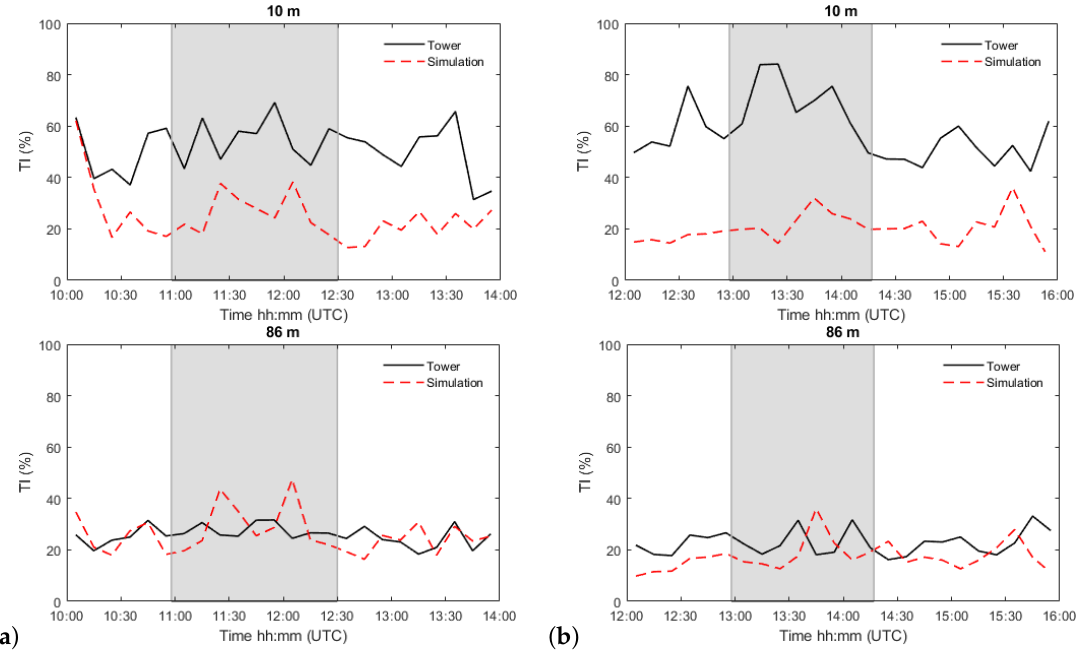
Figure 5. Time series of 10-min averages of horizontal turbulence intensity at 10 m and 86 m on 21 ( a ) and 22 ( b ) September. See also Figure